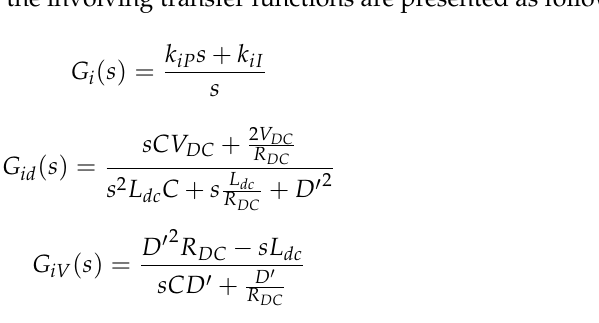
Figure 4. Open-loop control structure of DC/DC converter.